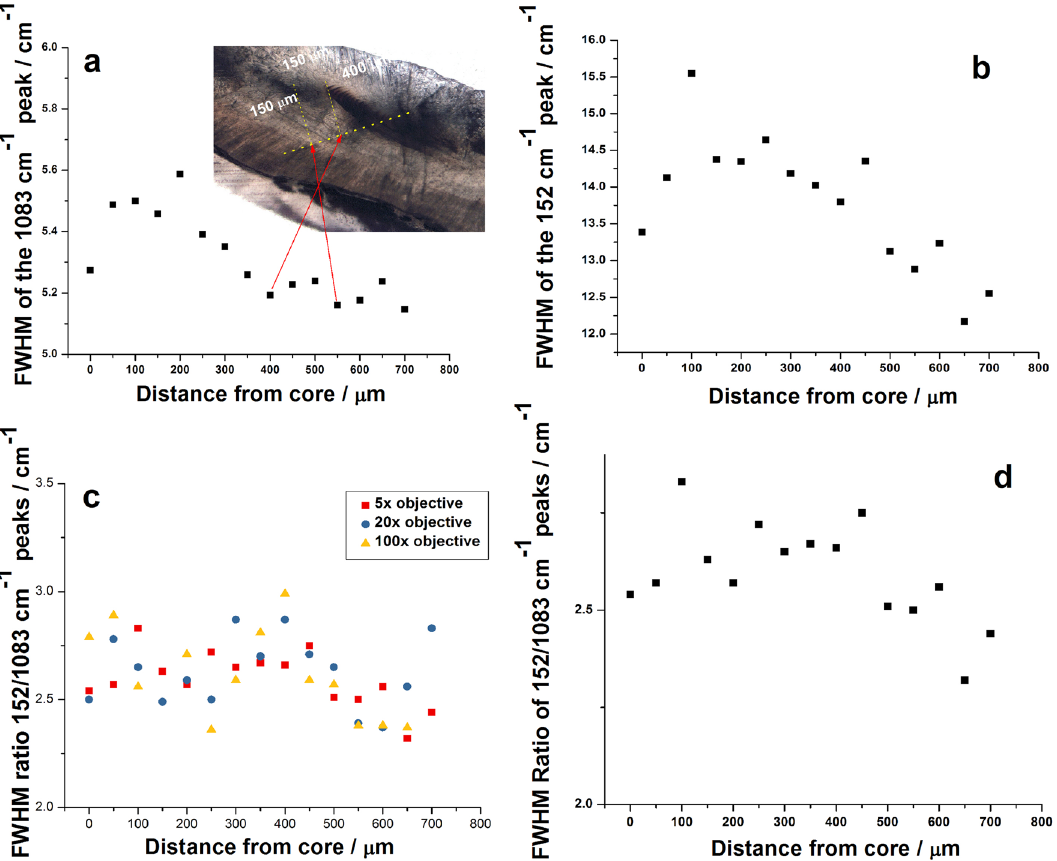
Figure 2. FWHM variation of the: ( a ) main carbonate Raman band (1083 cm −1 ), ( b ) lattice mode at 152 (cm −1 ), ( d ) the ratio of the 1083 and 152 cm −1 bands, along the growth line. ( c ) Comparison of the FWHM ratio (152/1083 cm −1 ), with different collecting objectives (5 ×, 20 × and 100